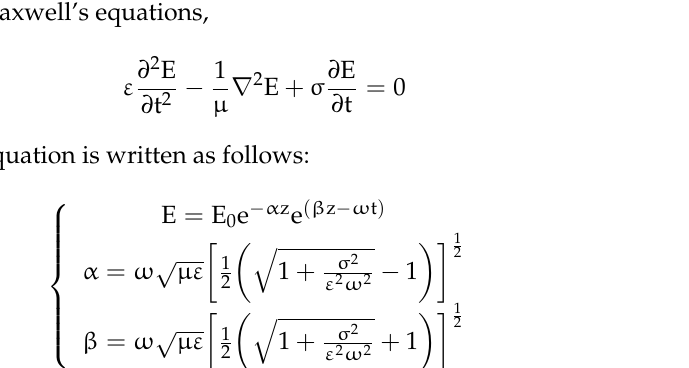
Figure 5. GPR image after gain.